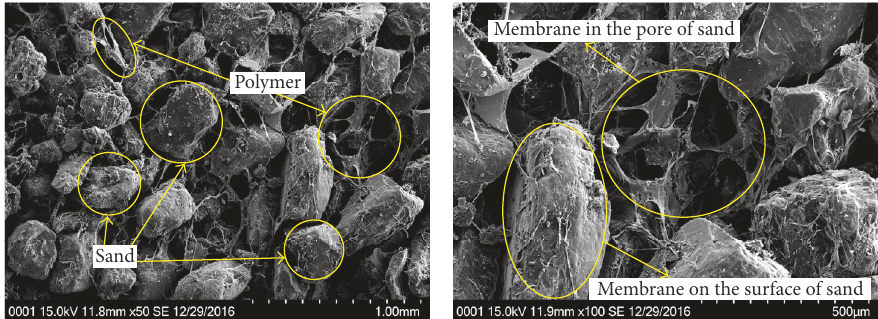
Figure 14: SEM images of specimen reinforced with polymer